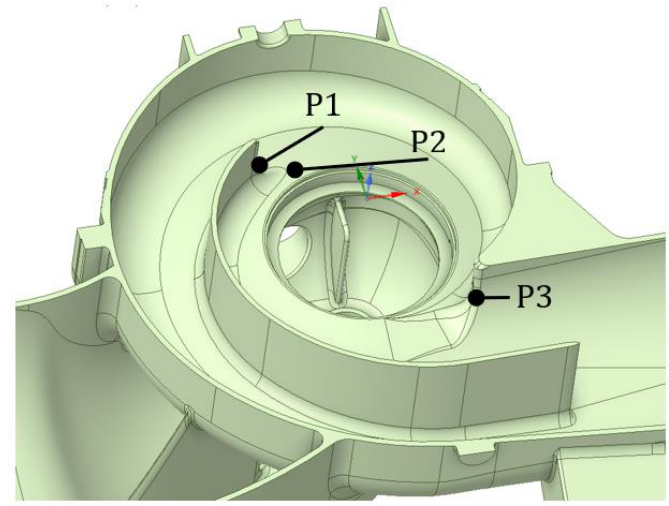
Figure 4. Location of monitoring points for the volute casing.